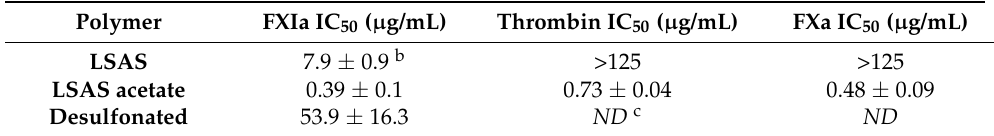
Table 6. Hydrolysis of the chromogenic substrate S-2366 by FXIa in the presence of desulfonated polymer a